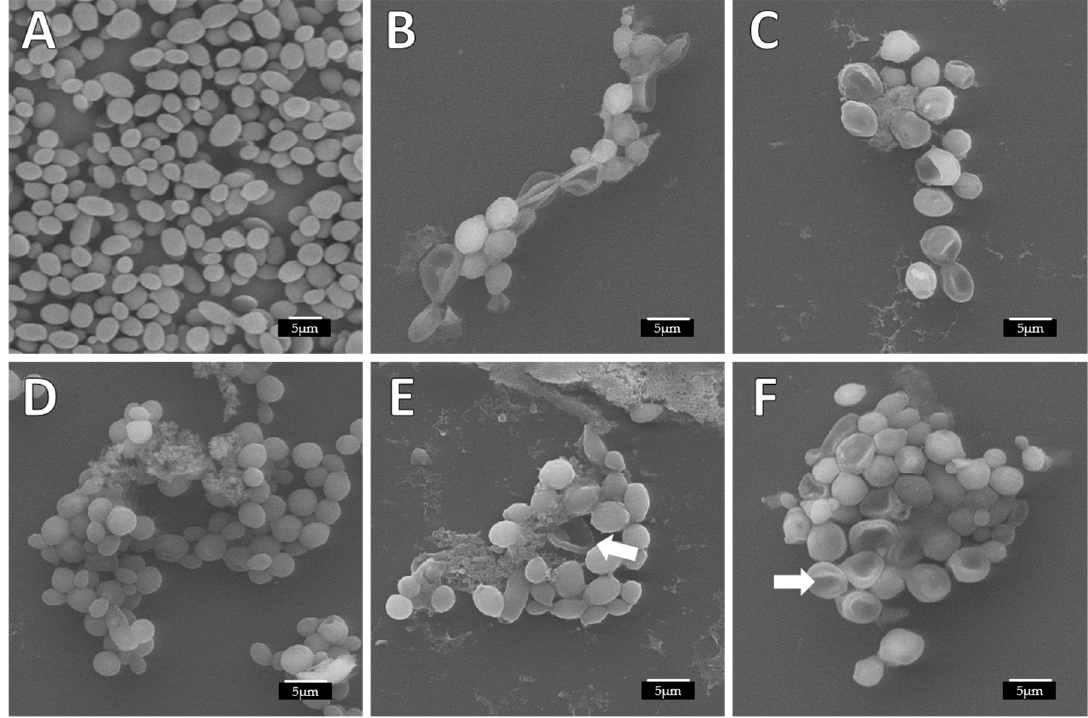
Figure 3. Alterations produced in C. albicans biofilm structure and cell morphology during the biofilm formation treatment observed by SEM. ( A ) Untreated; ( B ) ArCO 2 G 2 (SNMe 3 I) 4 ( 2 ) dendron alone to 8 mg/L ( C ) AgNO 3 alone to 8 mg/L; ( D ) EDTA alone to 32 mg/L; ( E ) combination ArCO 2 G 2 (SNMe 3 I) 4 ( 2 ):AgNO 3 to 8:4 mg/L; ( F ) combination ArCO 2 G 2 (SNMe 3 I) 4 ( 2 ):EDTA to 8:32 mg/L (white arrow: collapsed cells).